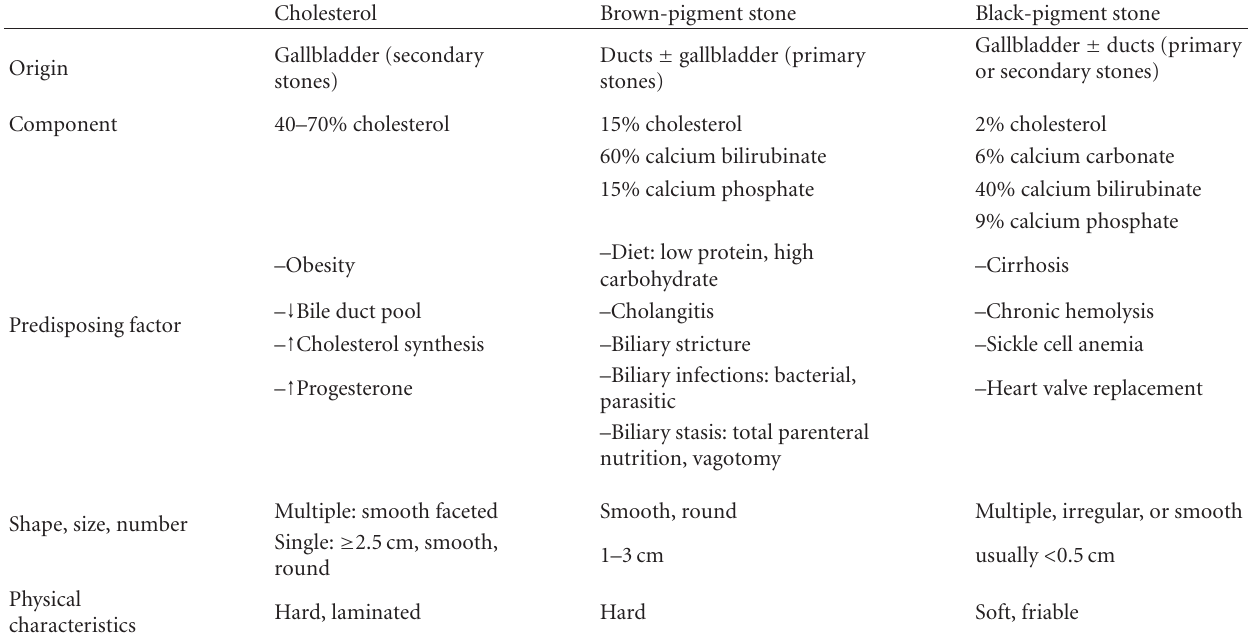
Table 1: Classification of gallstones